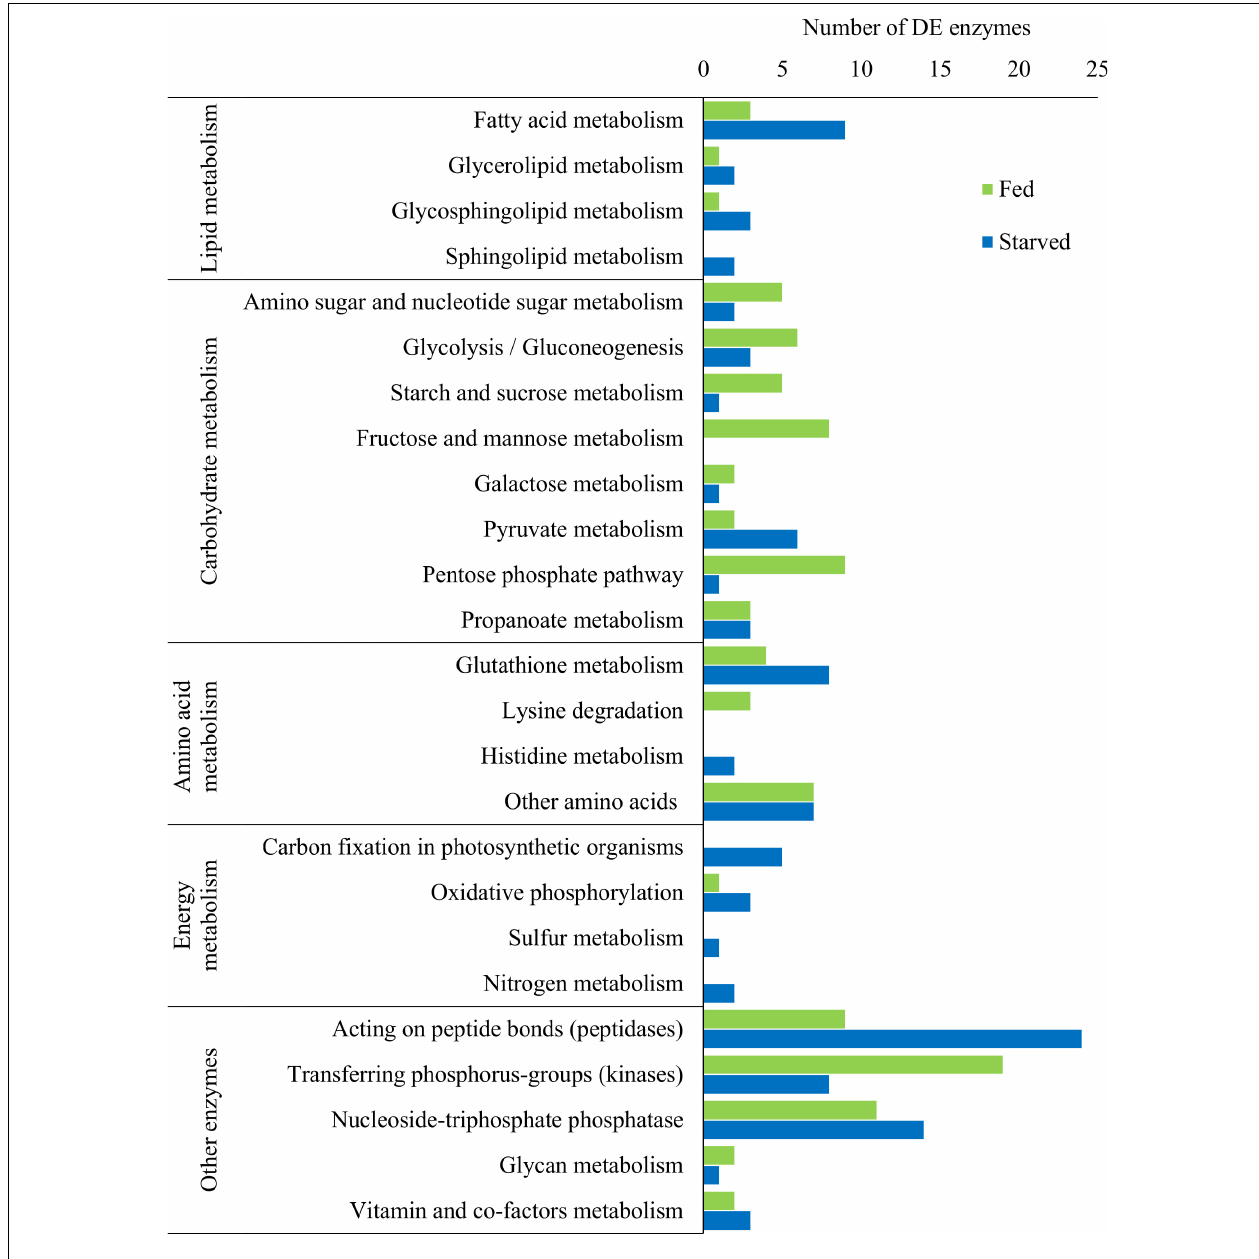
FIGURE 6 | Number of significantly differentially expressed (DE) putative KEGG enzymes across five broad metabolic categories in O. marina cells during feeding and